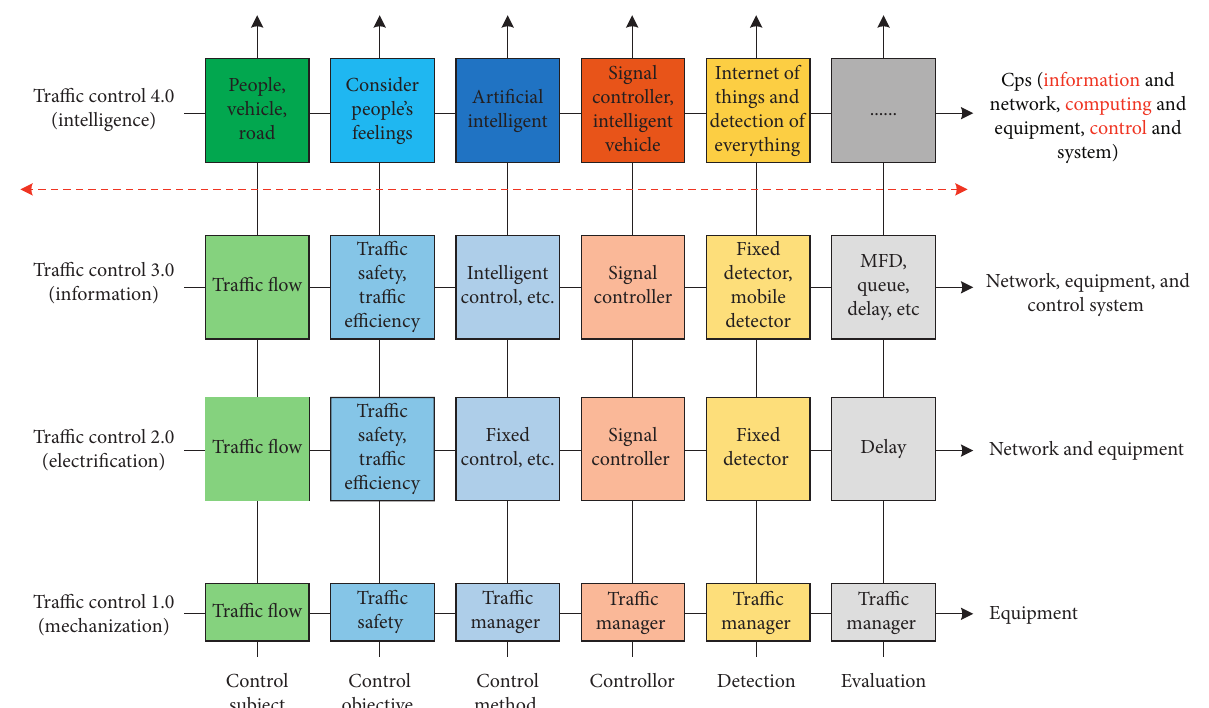
Figure 1: Development form of traffic